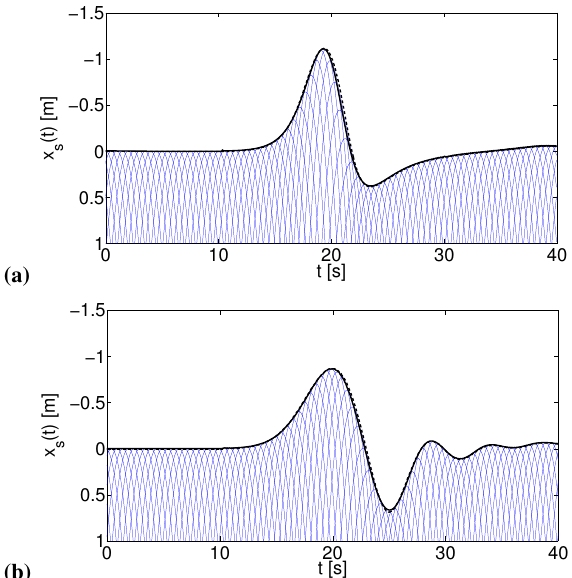
Fig. 7. The shoreline movement of a solitary wave for the linear Figure 7. The shoreline movement of a solitary wave for the linear model ( a : LSWE, b : LVBM) coupled to the NSWE (dashed line) model ( a : LSWE; b : LVBM) coupled to the NSWE (dashed line), and the linear model with an EBC implementation (solid line). Paths and the linear model with an EBC implementation (solid line). Paths of the first-order characteristic curves are shown by the thin lines. of the first-order characteristic curves are shown by the thin